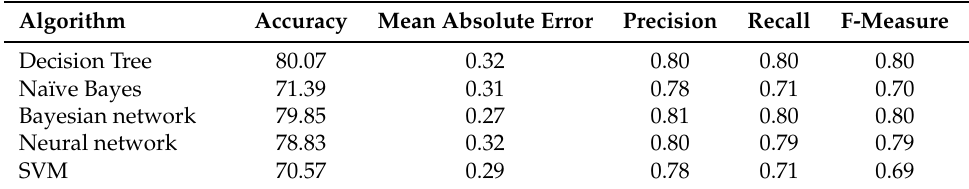
Table 15. LOC and readability metrics results for PCA dimension reduction approach using cross-